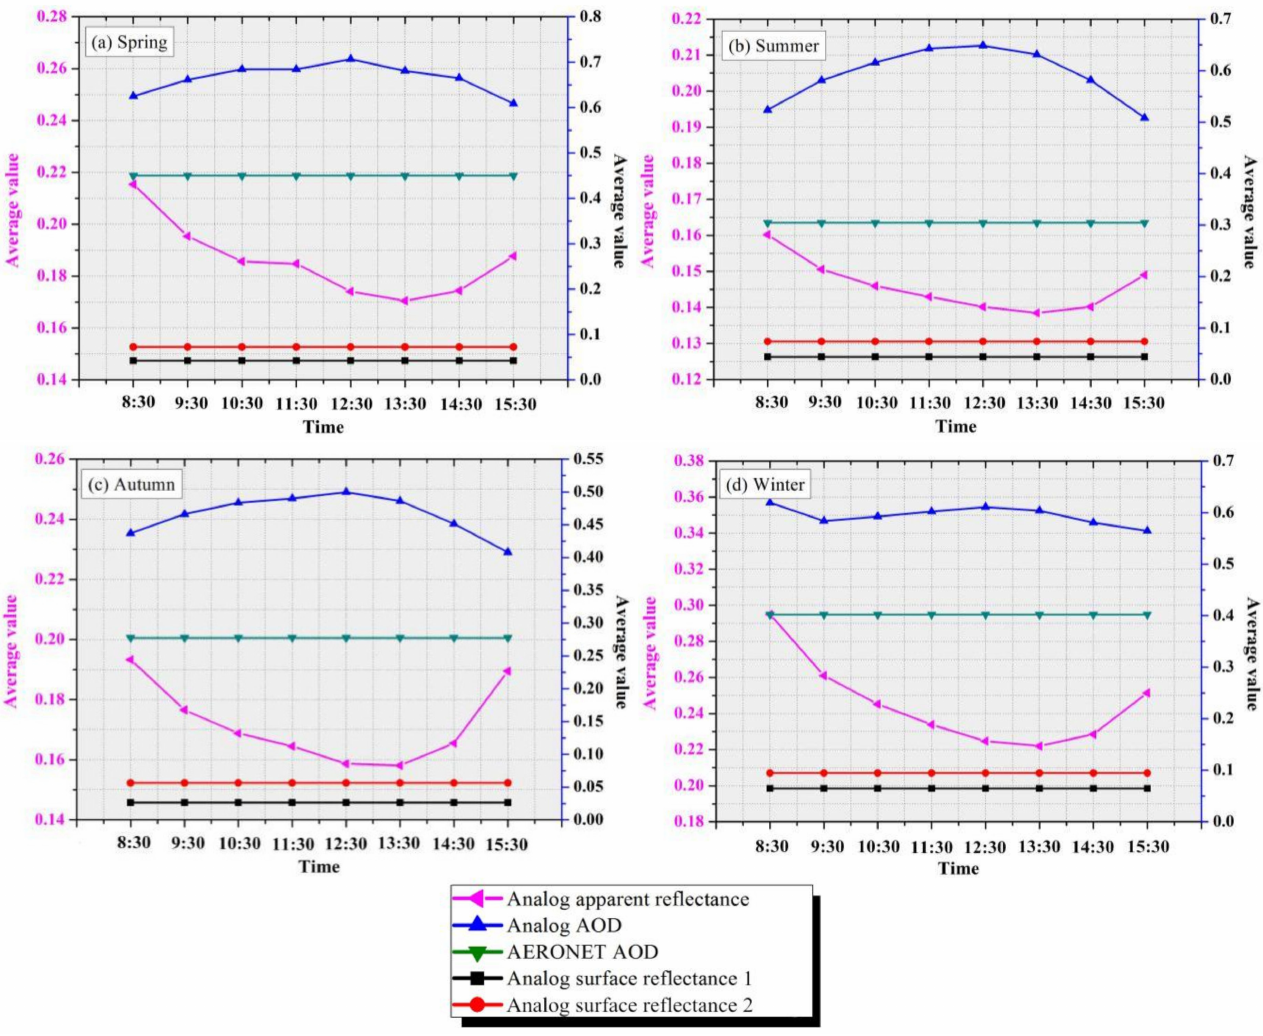
Figure 11. The influence of the four seasons on the retrieval of GOCI AOD. The ordinate of the apparent reflectance is the value on the left, and the ordinate of the other four curves are the value on the right).